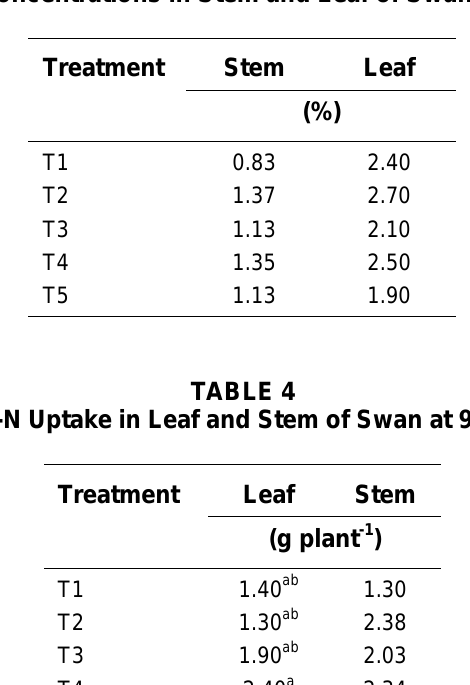
Urea-N Concentrations in Stem and Leaf of Swan at 90 DAP